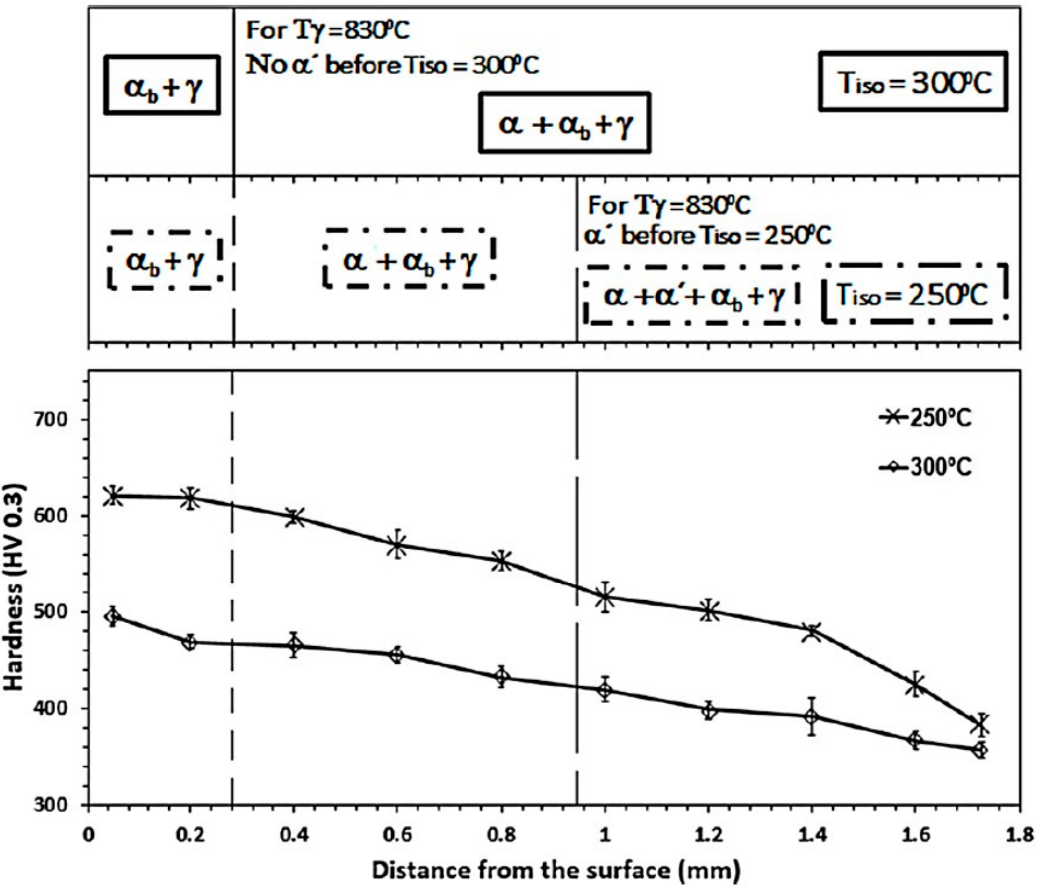
Figure 11. For T γ = 830 ◦ C. Hardness profiles of surface-carburized steels after isothermal Metals 2020 , 10 , x FOR PEER REVIEW 14 of 18 heat treatments.